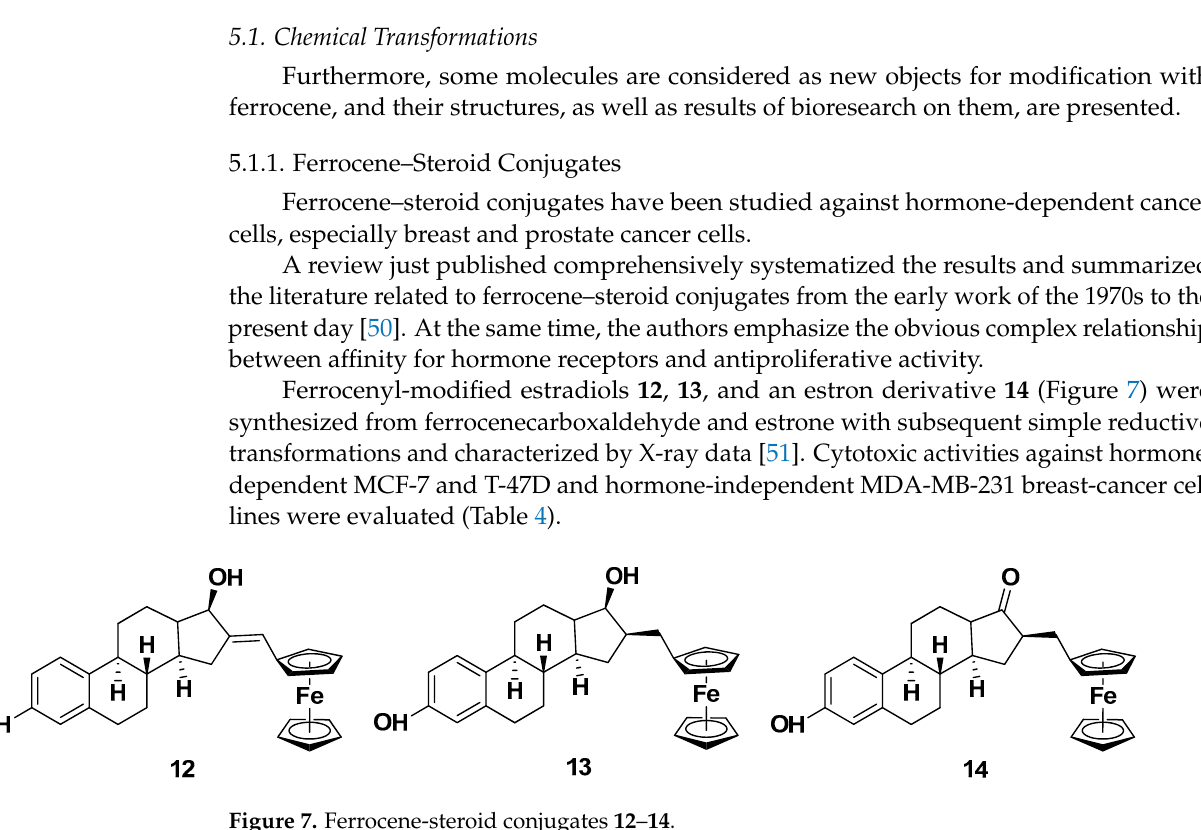
Figure 6. Ferrocene-modified tamoxifenes with succinimide ( 11a ), phthalimide ( 11b ), and other lactam substituents ( 11c ).